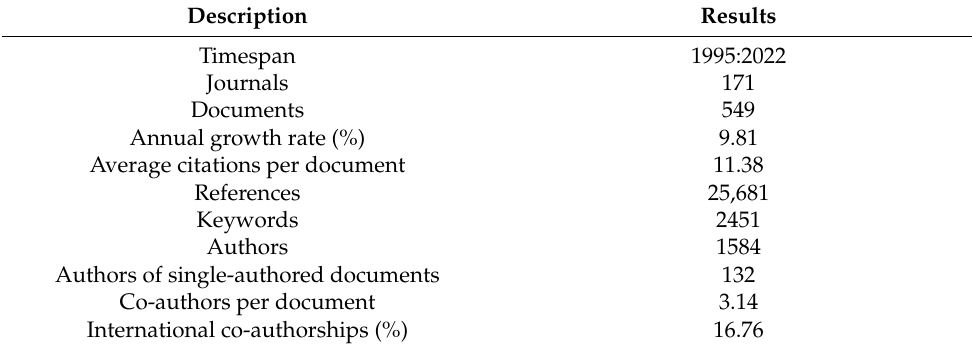
Table 2. Basic statistical